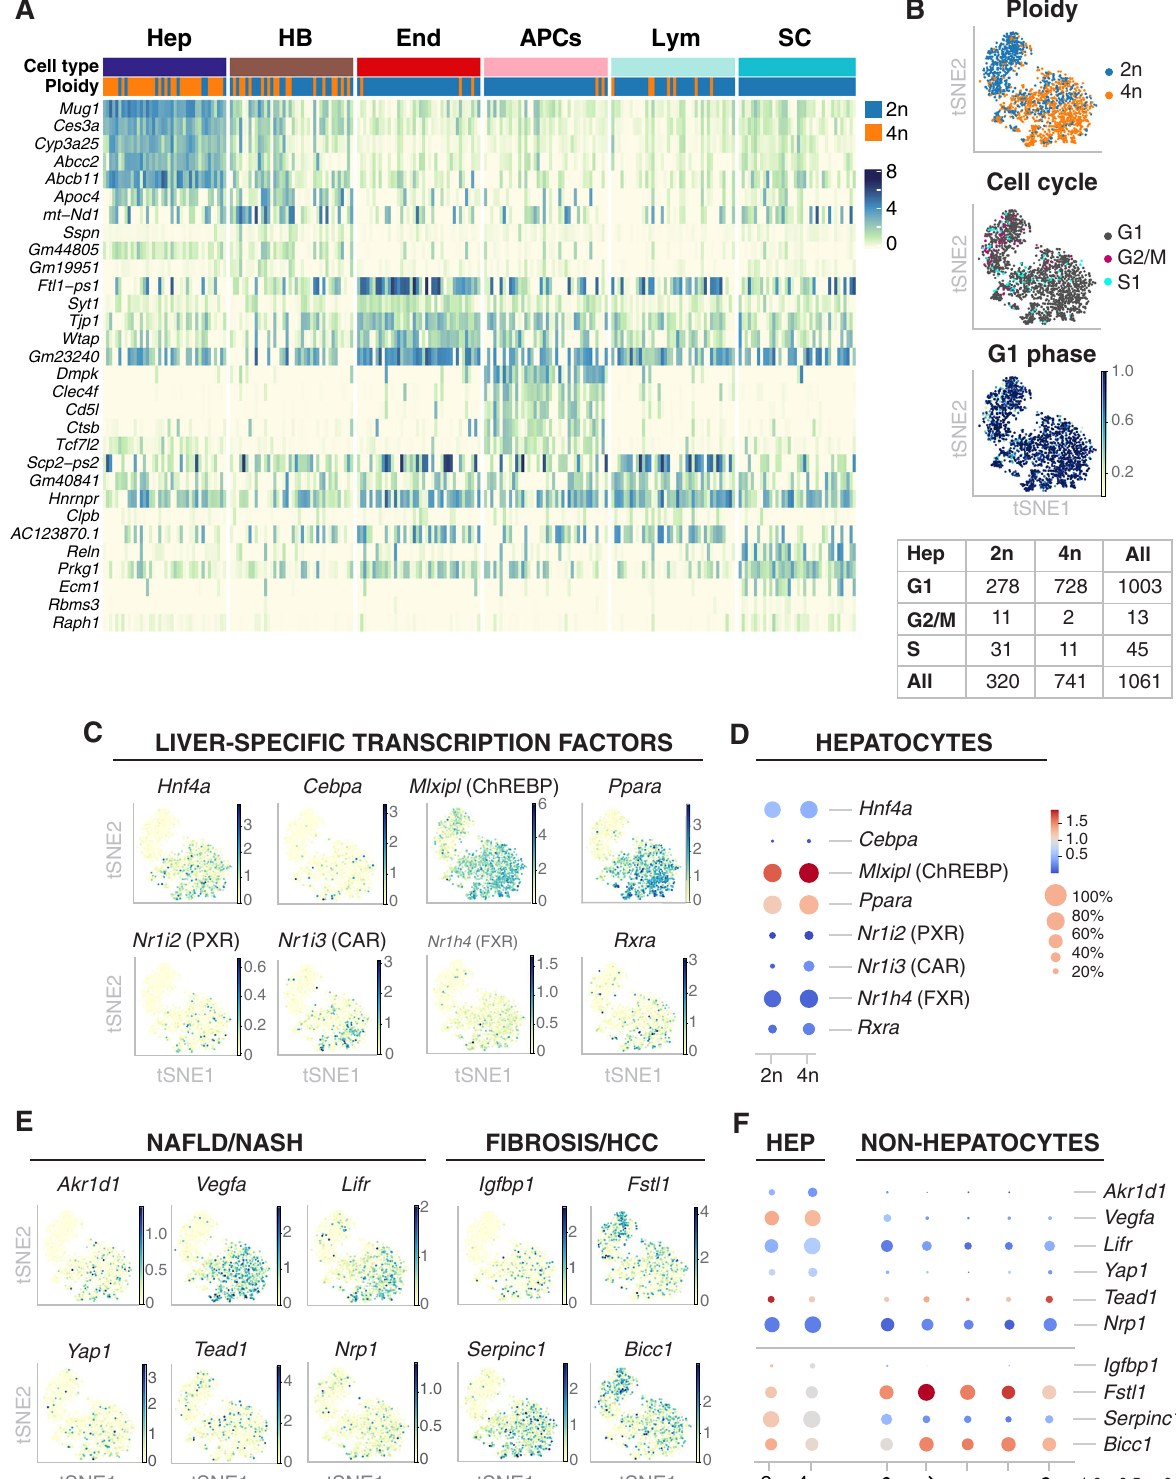
signi fi cantly lower coef fi cient of variation compared to 2n hepatocytes (2n are 1.09-times more variable than 4n, Mann – Whitney U-test, p- value 2.097e − 14) (Fig. 3D and Supp. Dataset 6). Accordingly, the number of highly variable genes (HVGs) was higher in the 2n hepatocytes compared to the 4n hepatocytes (Fig. 3D and Supp. Dataset